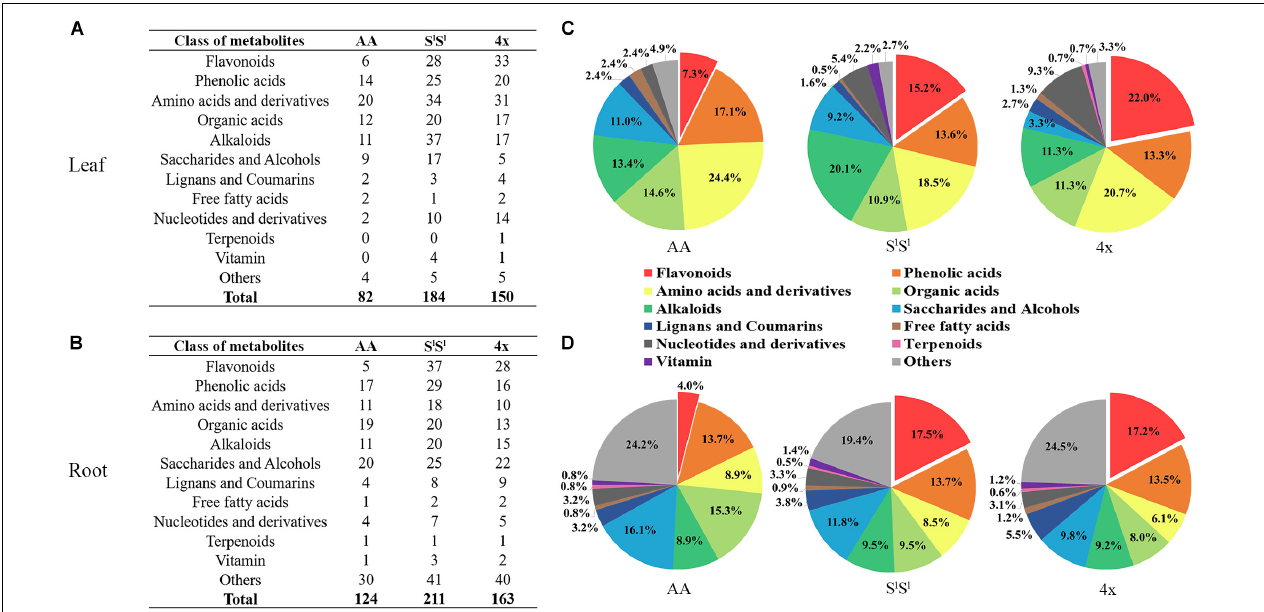
FIGURE 7 | Salinity stress response of different types of metabolites in synthetic tetraploid wheat and its diploid parents. The number of metabolites with stress-enhanced accumulation in leaf (A) and root (B) was displayed, and the pie diagrams showed proportion among different metabolite types with enhanced accumulation in leaf (C) and root (D) . The seedlings were exposed to 150 mM NaCl for 7